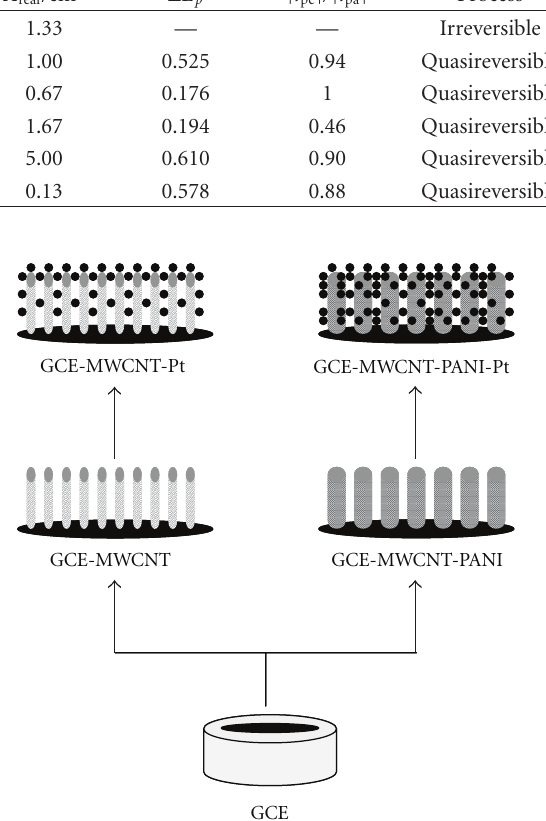
Figure 1: Schematic representation of the methodology used to prepare the modified GCE with MWCNT or MWCNT-PANI and Pt